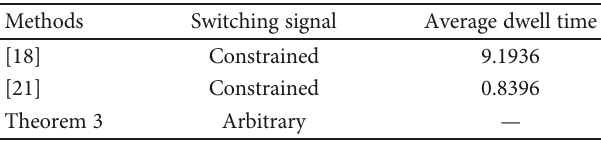
Figure 3: State norm responses of the subnetworks of the considered SNNs for Example 1.